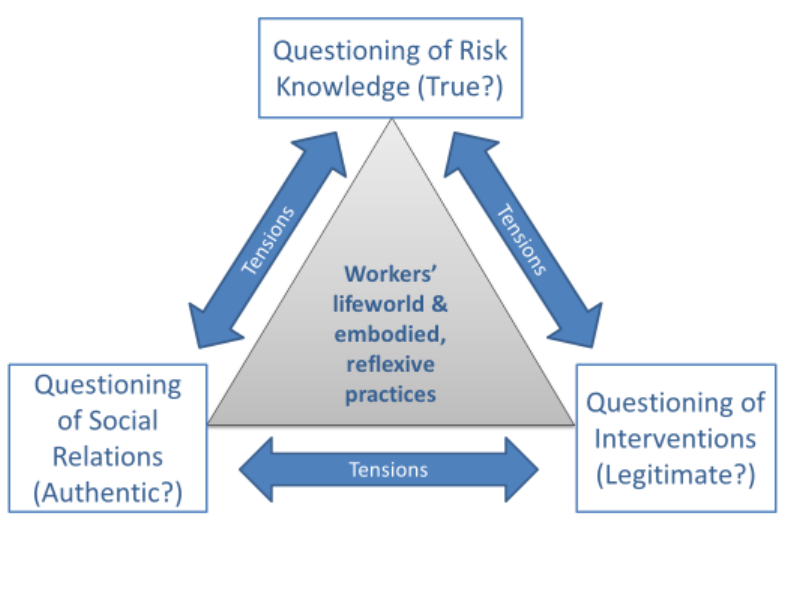
Figure 2. Tensions amid risk work may lead to workers questioning key